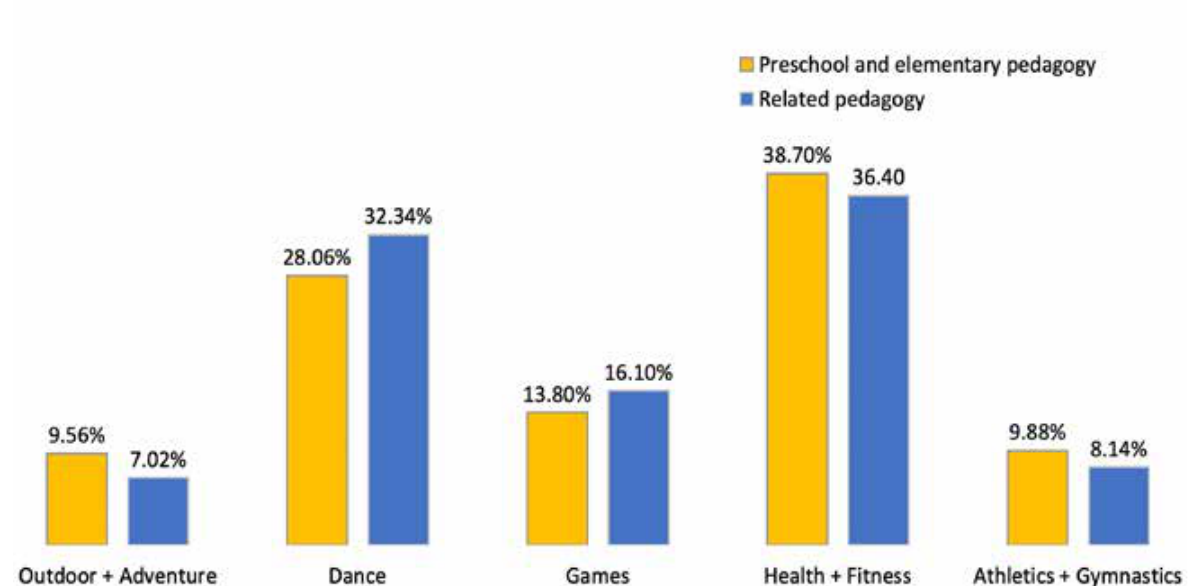
Figure 5. Demanding teaching activity in primary physical